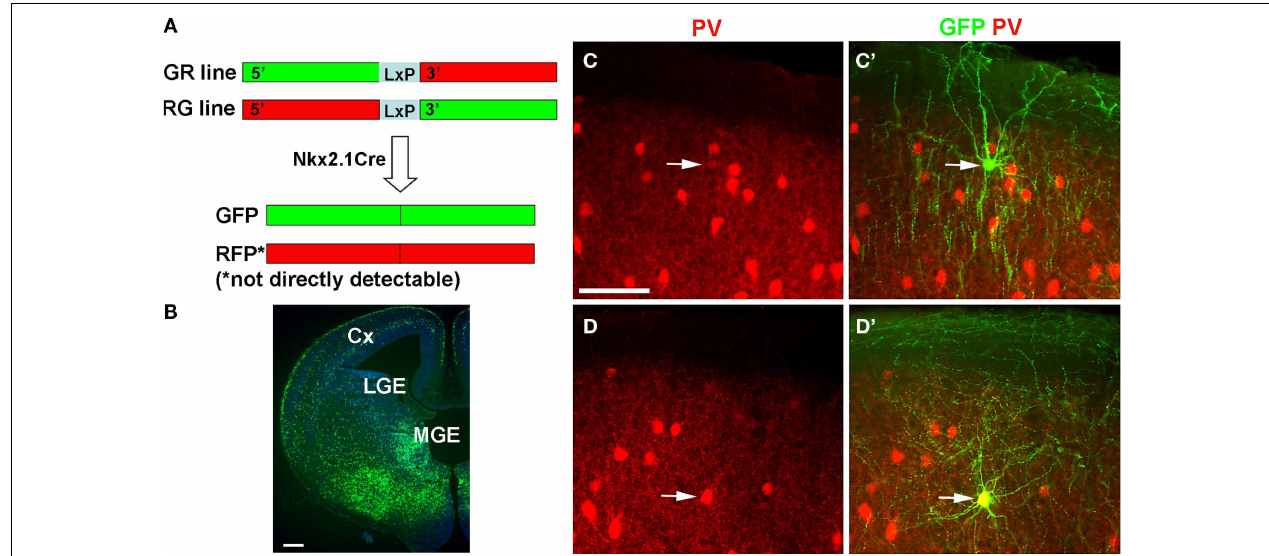
FIGURE 1 | Identifi cation of chandelier cells from Nkx2.1 MADM mice. (A) Genetic strategy. MADM GFP-5’, RFP-3’ (GR line), and RFP-5’, GFP-3’, were crossed to Nkx2.1Cre mice to generate mice that express directly visualizable GFP fl uorescence in sub-populations of Nkx2.1-lineage interneurons. (B) Section from an embryonic day (E) 14.5 Nkx2.1Cre:Z/EGFP reporter mouse. Recombination from this reporter is far more frequent than in the